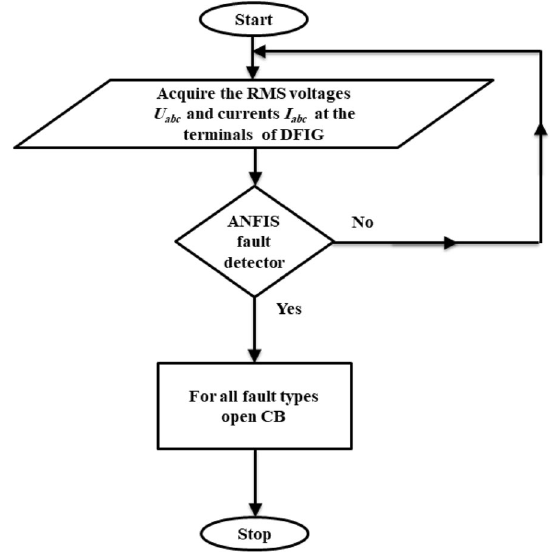
Fig. 3 ANFIS structure of classical protection technique for studied system